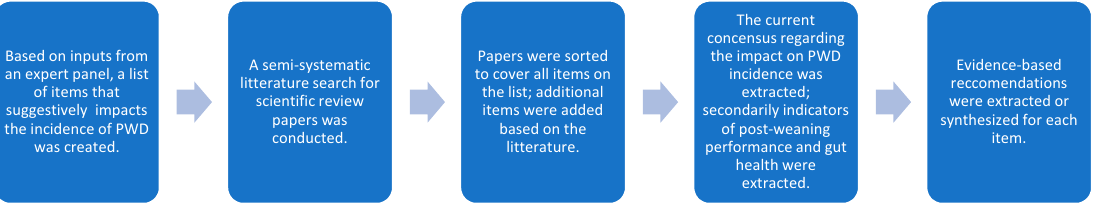
Figure 1. Outline of how we made our evidence-based recommendations.